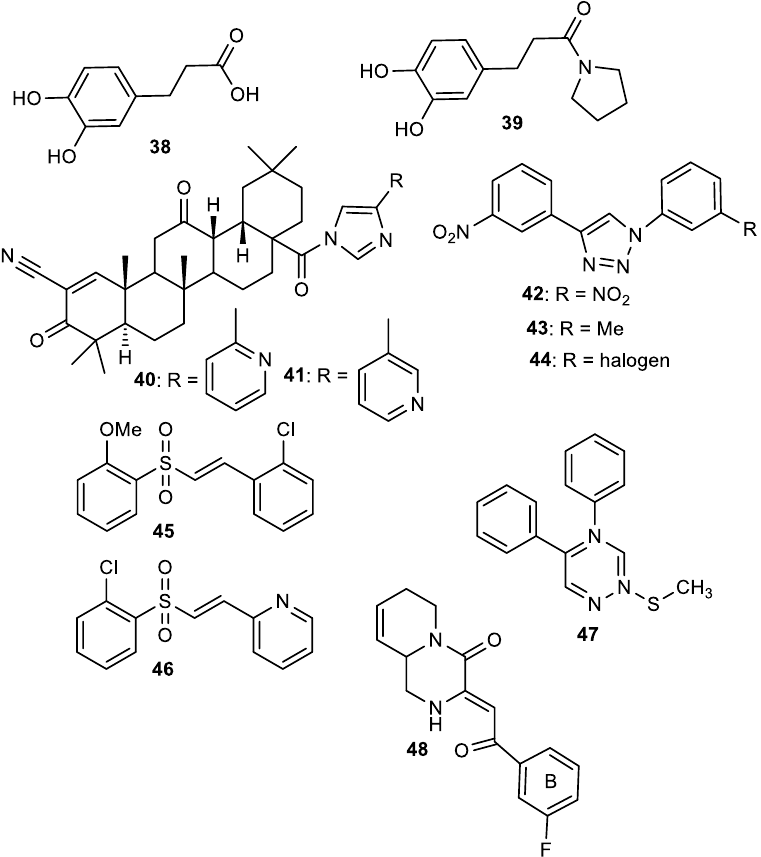
Figure 1. Structure – activity relationship (SAR) of NRF2-activating nitrogen heterocycle-containing molecules. The SAR assessment of molecules showed improved NRF2-inducing activity with the introduction of certain nitrogen heterocyclic compounds, as discussed in Section 4.